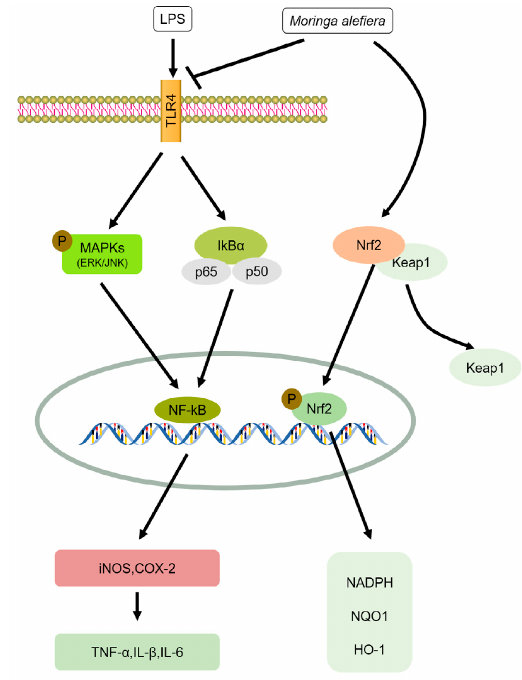
Figure 1. The anti-inflammatory mechanisms of M. oleifera. Schematic diagram illustrating the signaling pathways involved in the inhibitory effect of M. oleifera on proteins associated with LPS-induced inflammation summarized from a series of previous studies [17,19–22]. Toll-like receptor 4, TLR4; Nicotinamide adenine dinucleotide phosphate, NADPH; Inhibitor of kappa B, I κ B; Kelch-like erythroid cell-derived protein with cap’n’collar (CNC) homology (ECH)-associated protein 1, KEAP1. Lipopolysaccharide, LPS; mitogen-activated protein kinases, MAPKs; c-Jun N-terminal kinase, p-JNK; extracellular signal-related kinase, ERK; nuclear factor (erythroid-derived 2)-like 2, Nrf2; nuclear factor-kappa B, NF- κ B; inducible NO synthase: iNOS; cyclooxygenase-2, COX-2; tumor necrosis factor alpha, TNF- α ; interleukin-1 beta, IL- β ; interleukin-6, IL-6; quinone oxidoreductase 1, NQO1; heme oxygenase 1, HO-1.